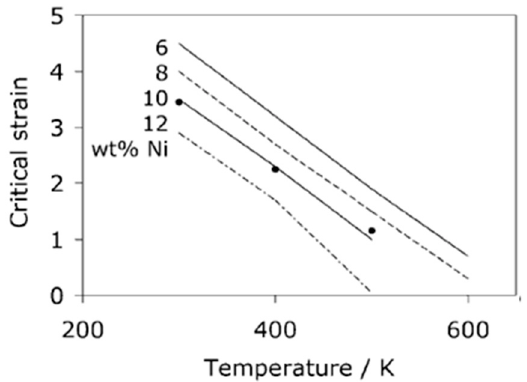
Figure 9. Critical values of plastic strain for mechanical stabilization of austenite in a 316L austenitic stainless steel. Extracted from reference [69]. Reproduced with permission from Taylor & Francis, 2017.